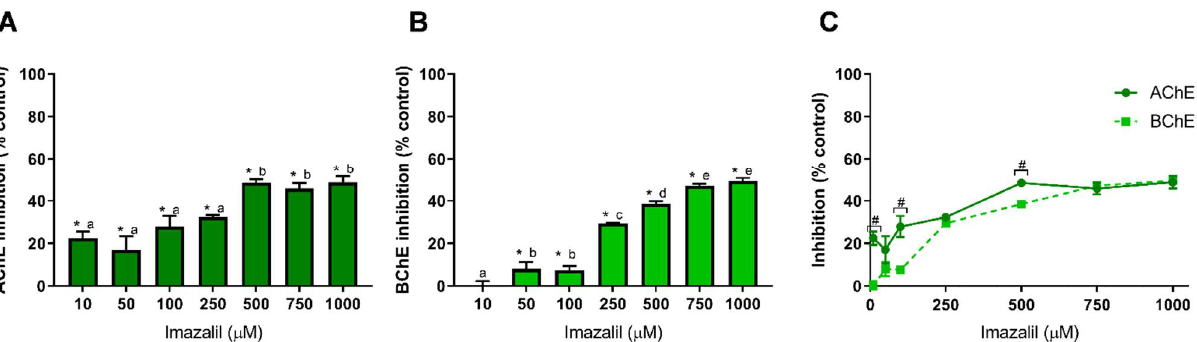
Figure 3. Imazalil-induced inhibition of AChE ( A ) and BChE ( B ), and comparison of cholinesterases affinity ( C ). Values are expressed as mean ± SD. Significant statistical differences between samples and the respective control are denoted by “*” when p < 0.05 ( A , B ), and statistical differences between enzymes at the same concentration are denoted by “#” when p < 0.05 ( C ). Different letters were used to denote significant differences between concentrations when p < 0.05 ( A , B ). Statistical analysis details are described in methods (Section 2.3) and in Table